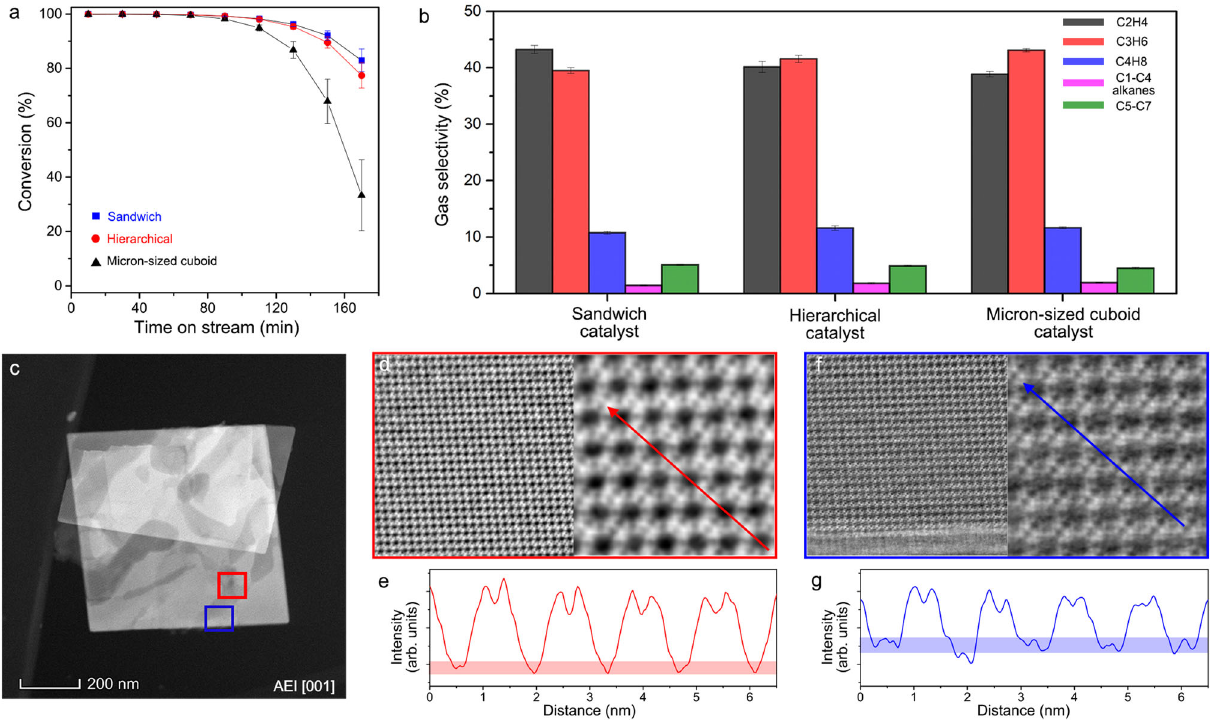
Fig. 5 Catalytic performances of SAPO-34/18 catalysts. a Conversion rates of methanol over three SAPO-34/18 catalysts. The blue, red, and black dots represent the results of sandwich, hierarchical, and micron-sized cuboid catalysts respectively. b Cumulative gas selectivity of the main products in the methanol conversion over three SAPO-34/18 catalysts, including light ole fi ns, light alkanes, and heavy hydrocarbons. c HAADF-STEM image of a sandwich crystal viewed from the AEI [0 0 1] projection. d – g iDPC-STEM images and the corresponding intensity pro fi les showing the coking at the areas inside the bulk ( d , e ) and near the surface ( f , g ), respectively. The error bars in ( a , b ) represent the standard deviations of four sets of data in repeated